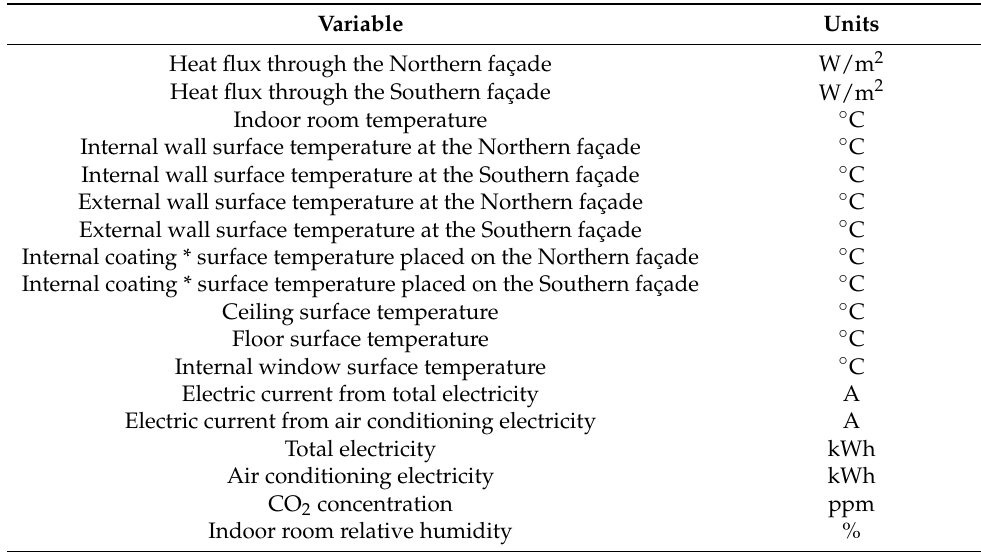
Figure 4. Scheme of the location of the monitoring sensors into the test cells. (Both were equipped with the same number and type of sensors). Table 2. Summary list of the monitored variables (both at the reference and test